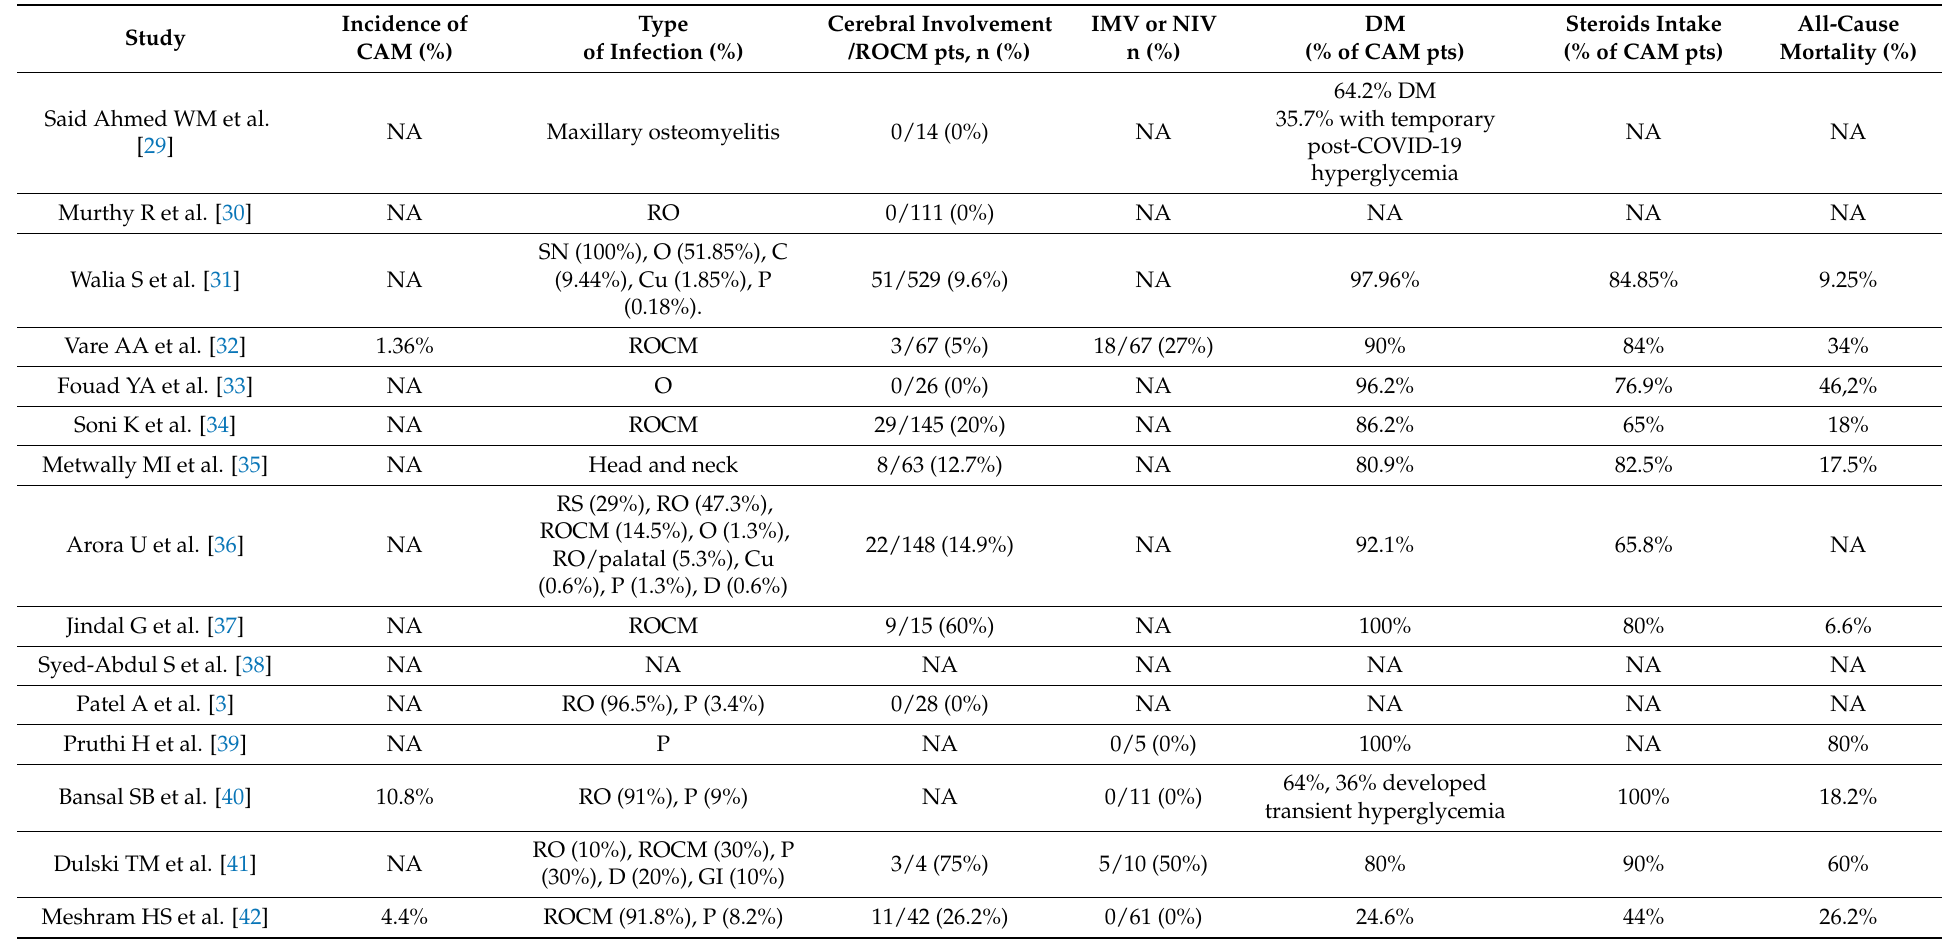
Table 2. Incidence of CAM among hospitalized COVID-19 patients, type of infection, invasive or non-invasive mechanical ventilation, risk factors and all- cause